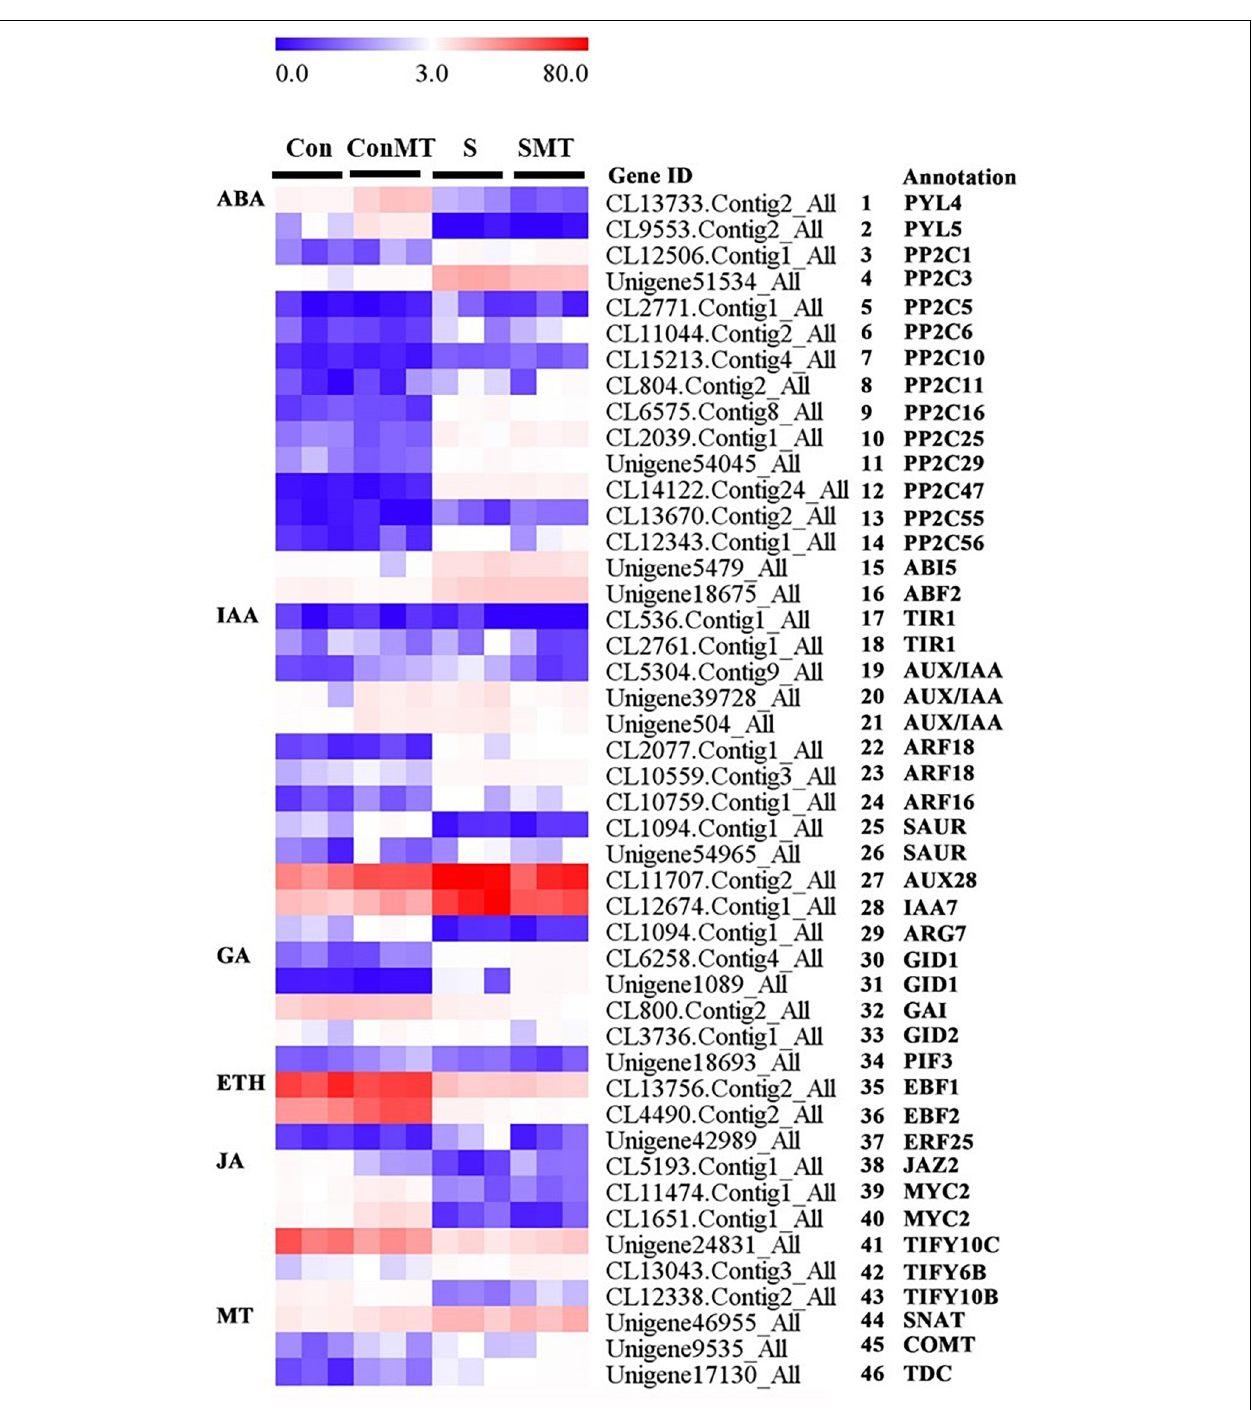
Frontiers in Plant Science |